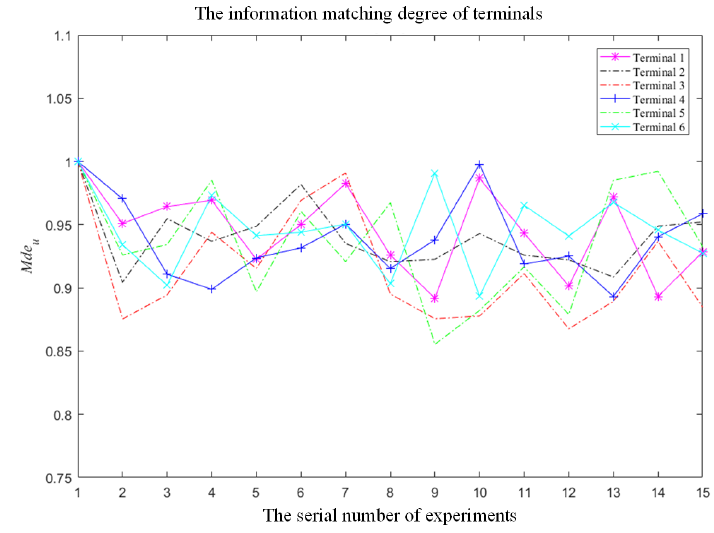
Figure 14. The information matching degree of